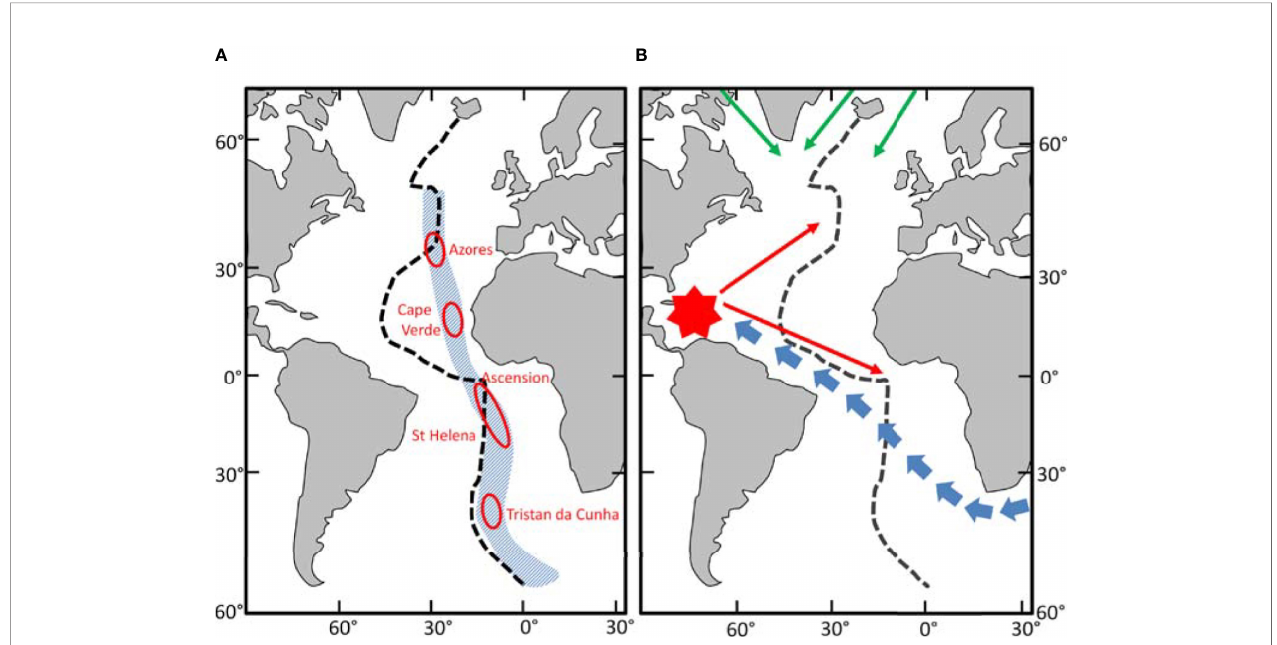
FIGURE 12 | Biogeography of the Atlantic Ocean. Dashed line Mid-Atlantic Ridge. (A) The faunistic boundary where East & West Atlantic species meet (Blue shaded area). Red Ovoids – Exotic regions. (After Mironov, 1994). (B) Pattern of late Cenozoic (from 10 MYA) colonisation of the Atlantic Ocean bathyal and sublittoral. Blue arrows – from Indo-West Paci fi c centre of re-distribution. Red symbol – West Atlantic centre of re-distribution. Green arrows – from the North Paci fi c via the Arctic Ocean (After Mironov,